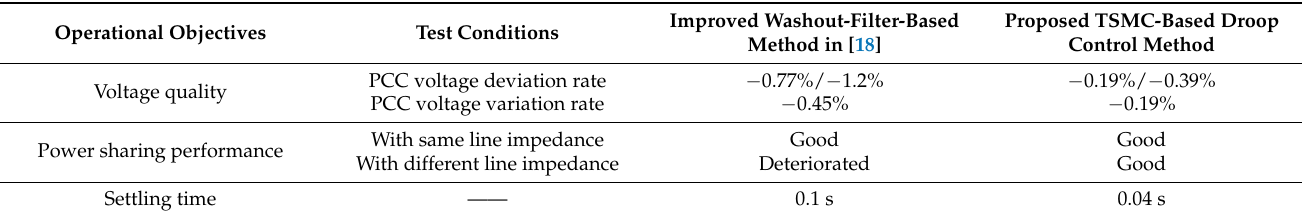
Figure 11. Waveforms with proposed TSMC-based power and voltage controller at different values of K and c 2 : ( a ) droop control relation error ( e p 1 ); ( b ) control effort of power control loop ( U 1 ); ( c ) active power sharing of parallel inverters; ( d ) voltage amplitudes of PCC voltage. Table 3. Performance comparisons of proposed method in this study and improved washout-filter-based method in